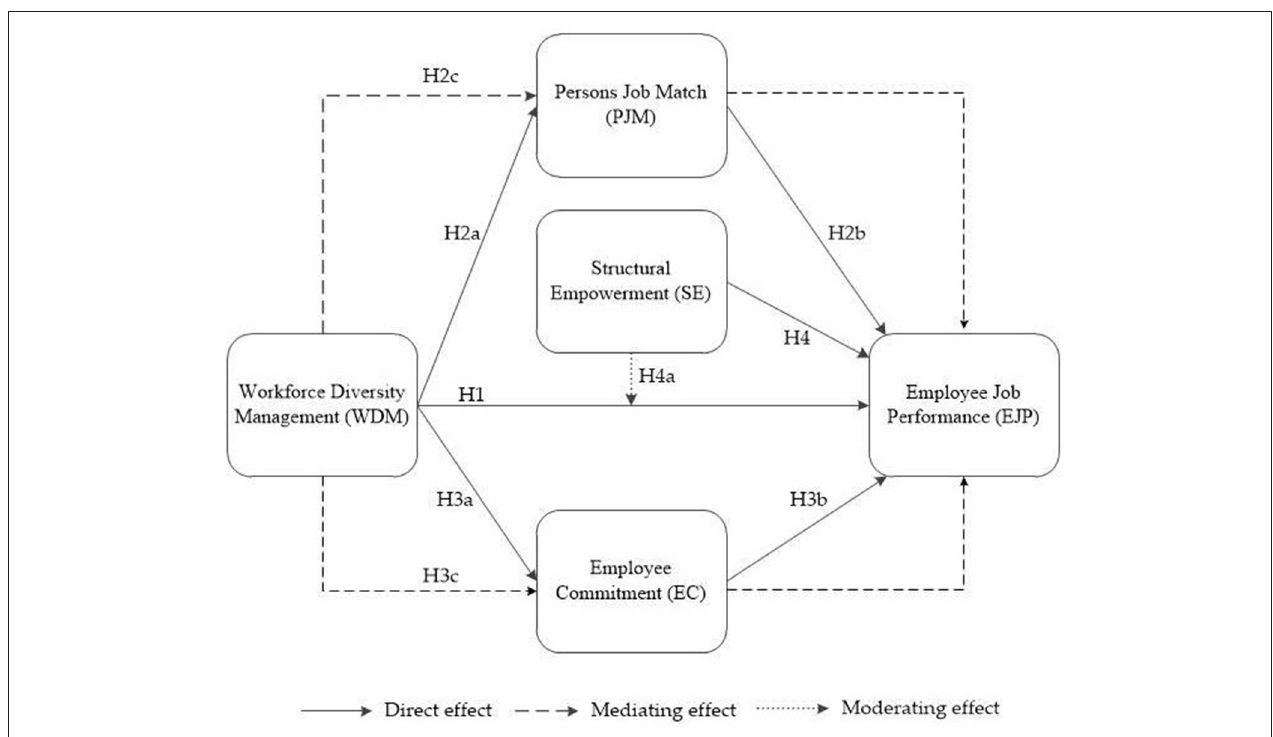
FIGURE 1 | Conceptual model. WDM, workforce diversity management; PJM, person job match; EC, employee commitment; SE, structural empowerment; EJP, employee job